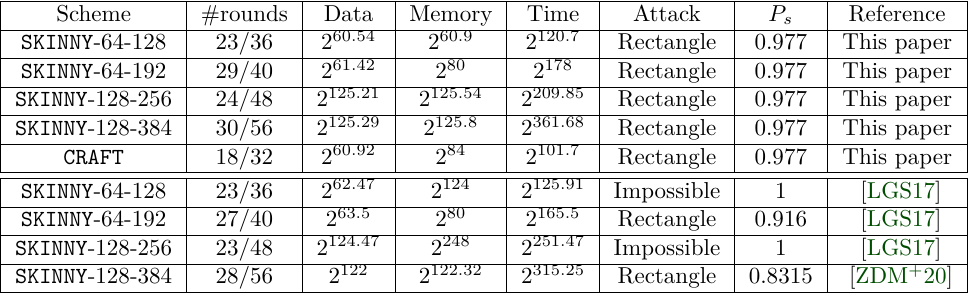
Table 1: Summary of results of the key recovery attacks on the variants of SKINNY and CRAFT .